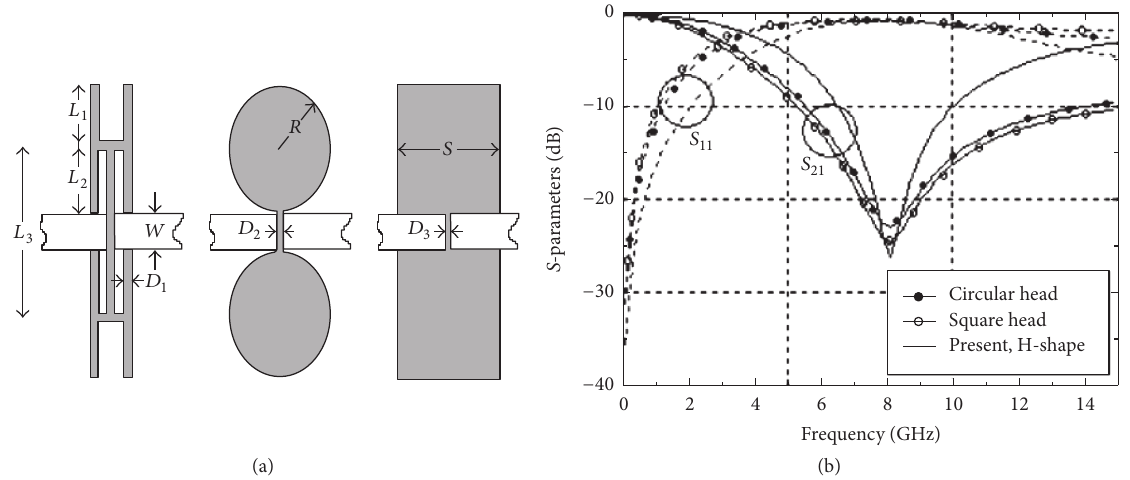
Figure 13: DGS structures. Solid lines indicate the slots etched in the ground plane of the microstrip: (a) different DGS; (b) 𝑆 -parameter response [42].